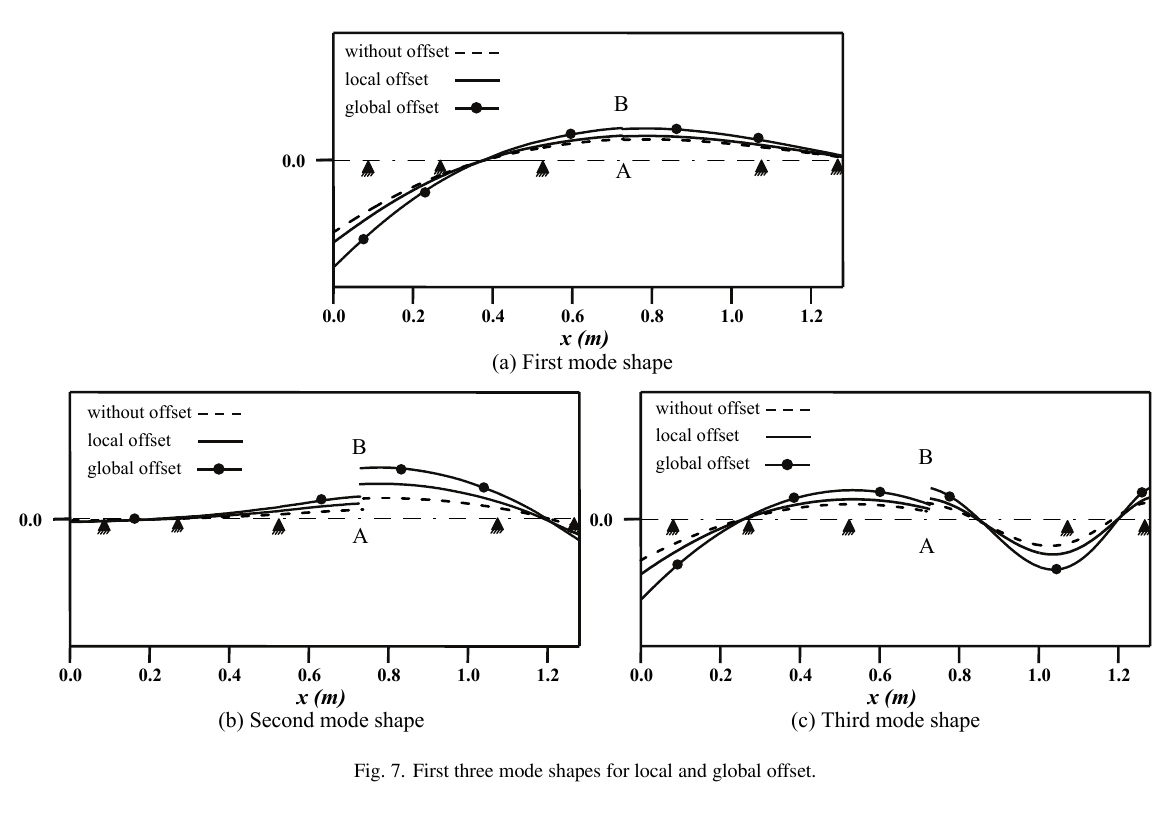
Fig. 7. First three mode shapes for local and global offset.